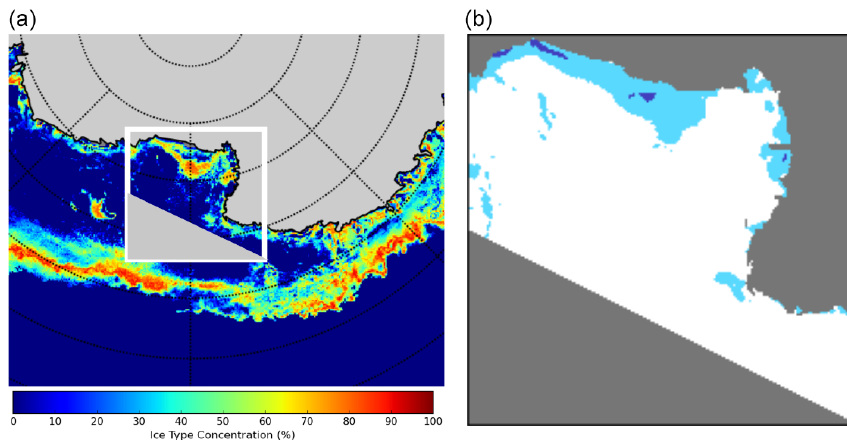
Figure 8. (a) Map of YI, 7 September 2017; (b) PSSM polynya map in the area indicated by the white rectangle in the YI map (dark blue: open water, light blue: thin ice, white: other ice, grey: masked-out area).